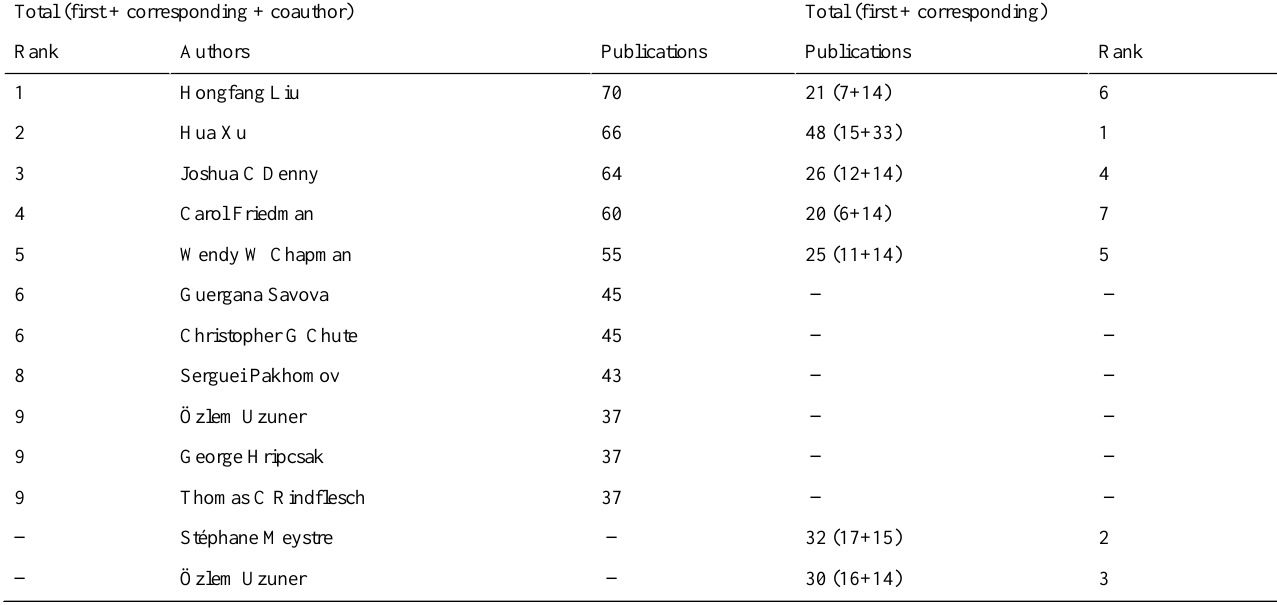
Table 2. Rank of top authors by number of articles published and the most articles published as the first plus corresponding author.